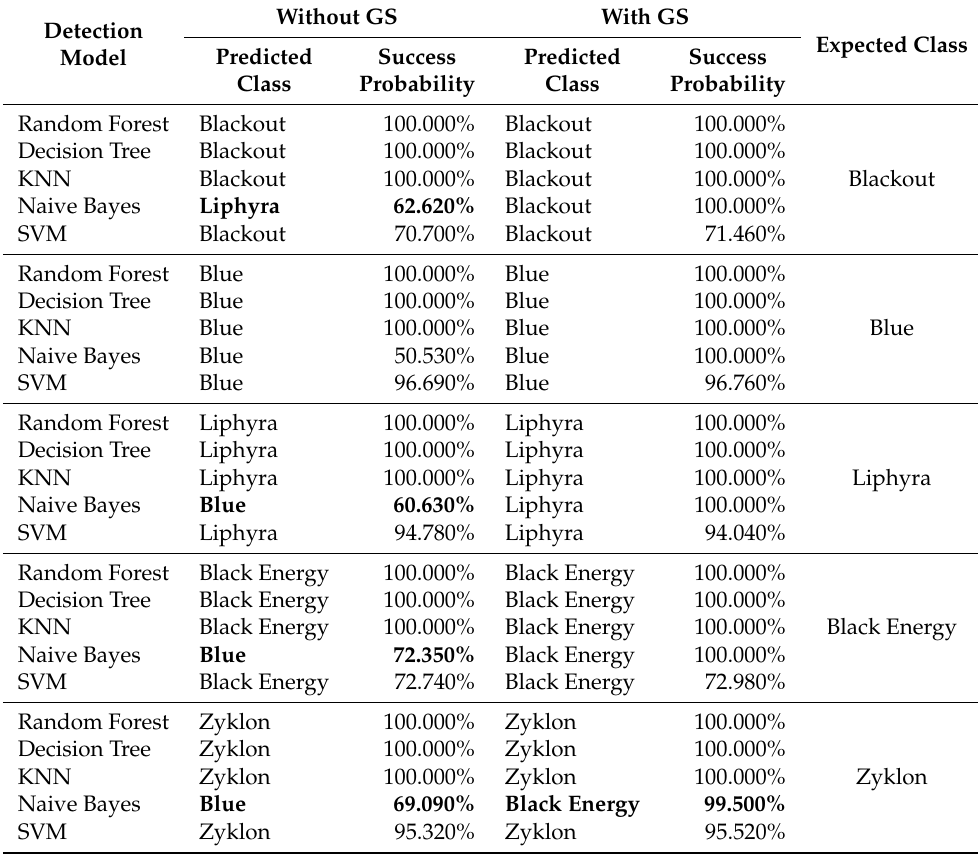
Table 12. Prediction results using minority classes included on the ISOT HTTP Botnet Dataset.